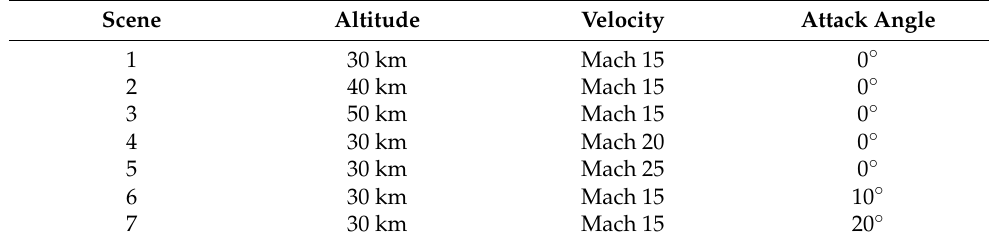
Table 1. Flight scenes of the hypersonic target.